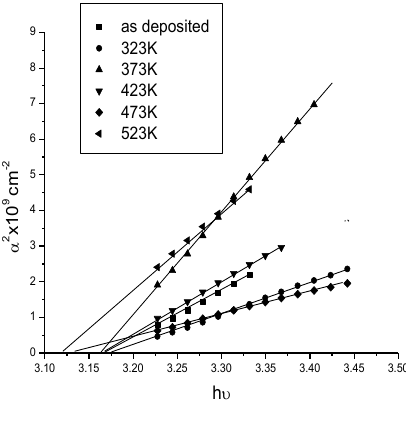
Figure 3. α 2 versus hυ graph of the H